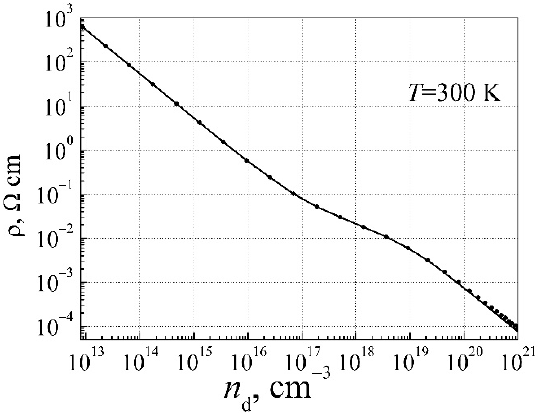
Figure 7. The resistivity dependence on the donor density in silicon at room temperature. Here the dots are the experimental data [4,26], the solid line is the calculated curve by using n eff and < E >.